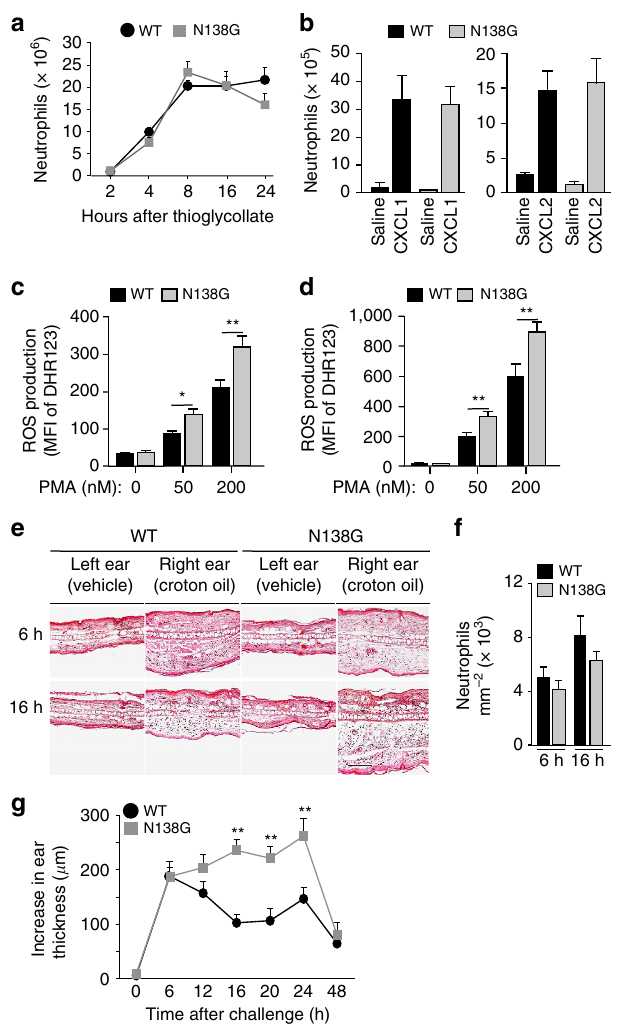
Figure 6 | Neutrophil priming in N138G mice delays healing after sterile injury. ( a ) Number of neutrophils recovered by lavage from the peritoneum at the indicated time after intraperitoneal injection of thioglycollate. ( b ) Number of neutrophils recovered by lavage from air pouches 4h after injection with saline, CXCL1 or CXCL2. ( c ) ROS generated in response to PMA by peritoneal neutrophils recovered 4h after injection of thioglycollate. ( d ) ROS generated in response to PMA by air-pouch neutrophils recovered 4h after injection of CXCL1. ( e ) Representative haematoxylin/eosin-stained ear sections 6h or 16h after topical application of vehicle or croton oil. Bar, 200 m m. ( f ) Number of neutrophils, quantified by myeloperoxidase staining, in ear sections 6h or 16h after topical application of croton oil. ( g ) Increase in ear thickness at the indicated time after application of croton oil. Data are mean ± s.e.m. of four experiments with three mice per group. * P o 0.05; ** P o 0.01 (two-tailed Student’s t test).